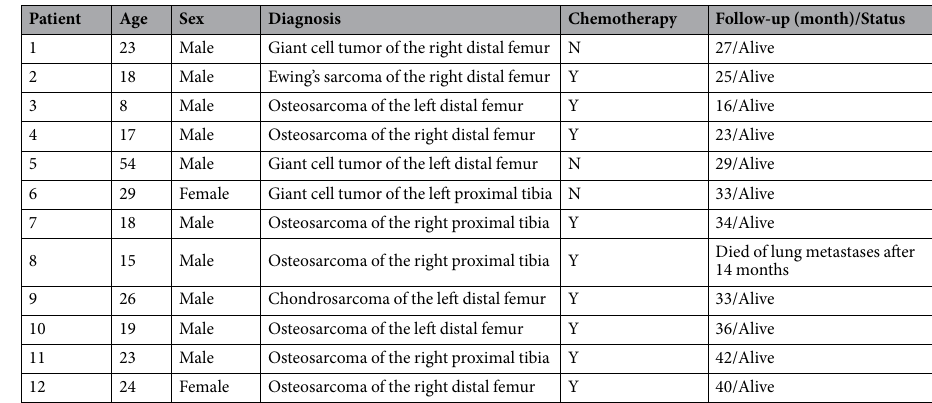
Table 1. The demographic characteristics of 12 patients (Inclusion criteria: Clinical diagnosis of primary malignant bone tumors in the distal femur or proximal tibia according to the preoperative biopsy; Bearing malignant soft tissue tumor that invades distal femur or proximal tibia. Exclusion Criteria: Distant metastasis; Benign tumor; Metastatic tumor around the knee; No indication of limb salvage; Malignant soft tissue tumor without bone invasion; Recrudescent